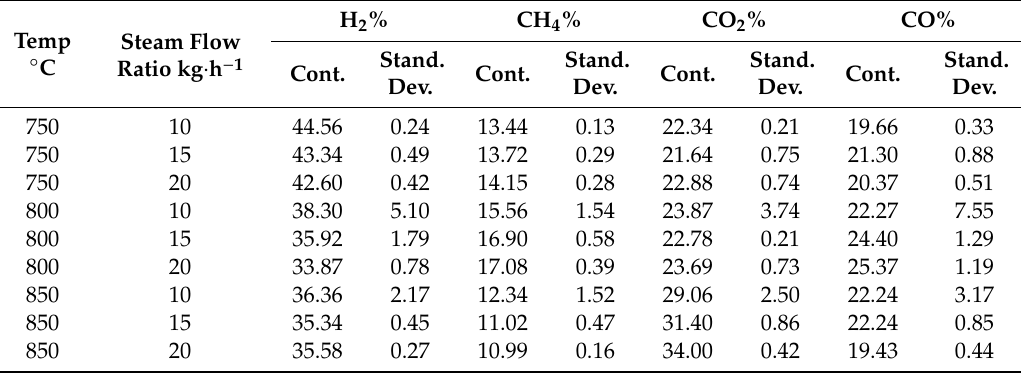
Table 3. Averaged measurement results with standard deviations.